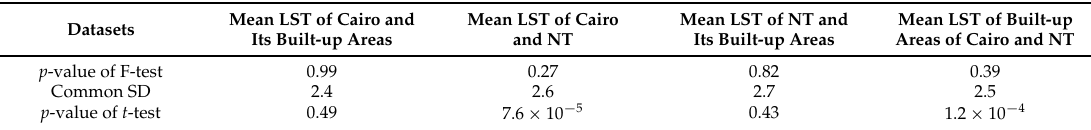
Table 4. The results of F-test and t -test with the common SD (Standard Deviation) of the pair mean LST